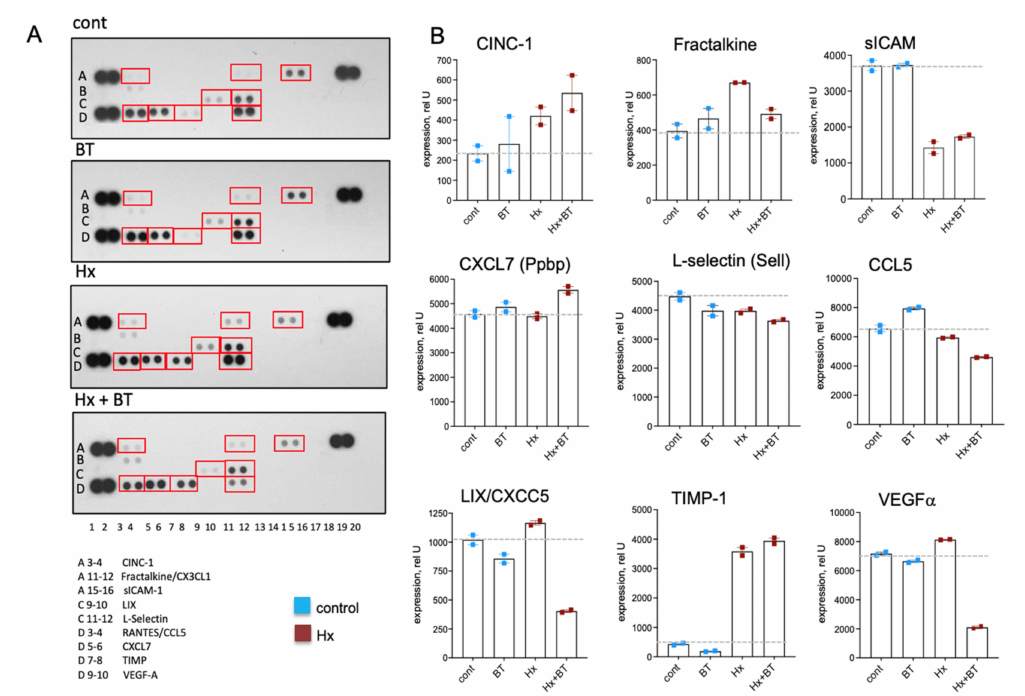
Figure 7. Butyrate modulates cytokine levels in the lungs. Cytokine levels were measured in total lung lysates using a Proteome Profiler TM Array. An equal amount of protein from six animals of the same experimental condition was pooled, and 400 µ g of pooled lysate were used for the assay and loaded in duplicates; data represent a mean +/ − SED; ( A ): Cytokine array panels showing the various cytokines in rat lung extracts; ( B ): Densitometric analysis of cytokine